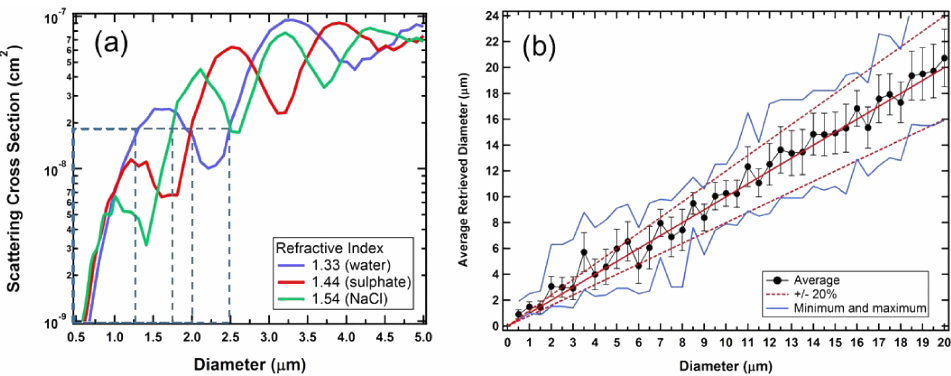
Figure 8. (a) Theoretical scattering cross section (Mie, 1908) of spherical particles as a function of diameter for three refractive indices and the collection angles of the CAS-POL. Only a small size range is shown in order to illustrate the potential magnitude of uncertainty. The dashed lines show that particles with four different sizes have the same scattering cross section. (b) Average retrieved diameter for a given size at a refractive index of 1.48. Vertical bars represent 1 standard deviation around the mean. The red lines are the one-to-one (solid) and ± 20% (dotted) around the one to one. Blue lines correspond to maximum and minimum errors for each diameter.